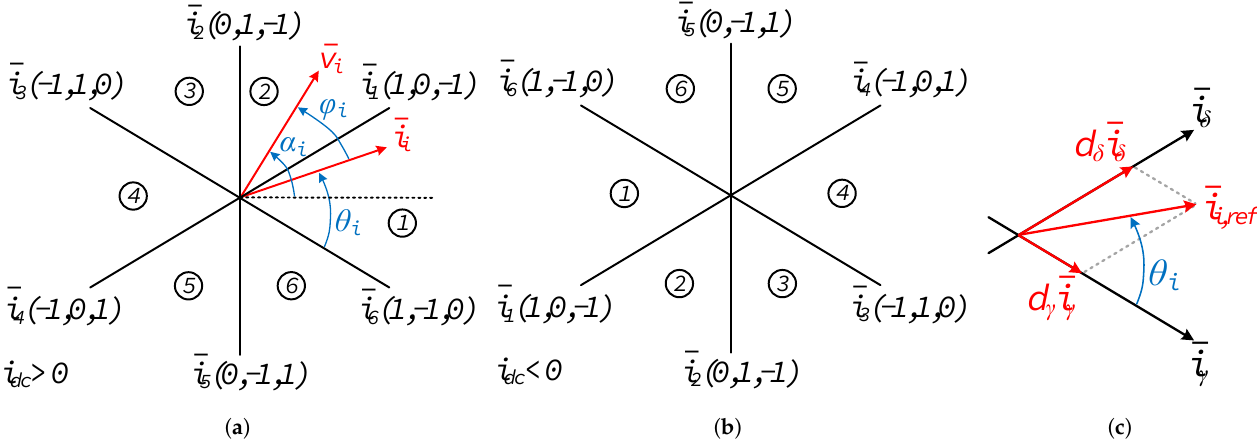
Figure 11. Input current SSVs in αβ frame when ( a ) i dc > 0 and ( b ) i dc < 0. ( c ) Generation of input current reference vector i i , ref